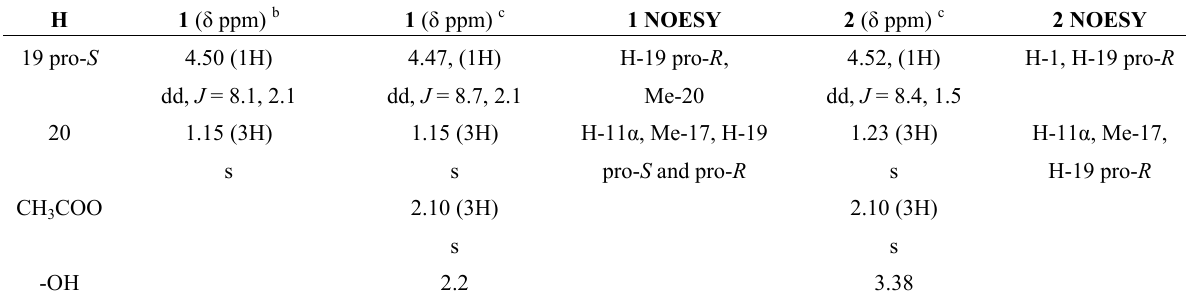
Table 2. 13 C-NMR data for compounds 1 and 2 . (75 MHz, CDCl